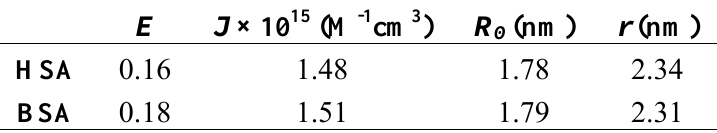
Table 2 . Förster energy transfer